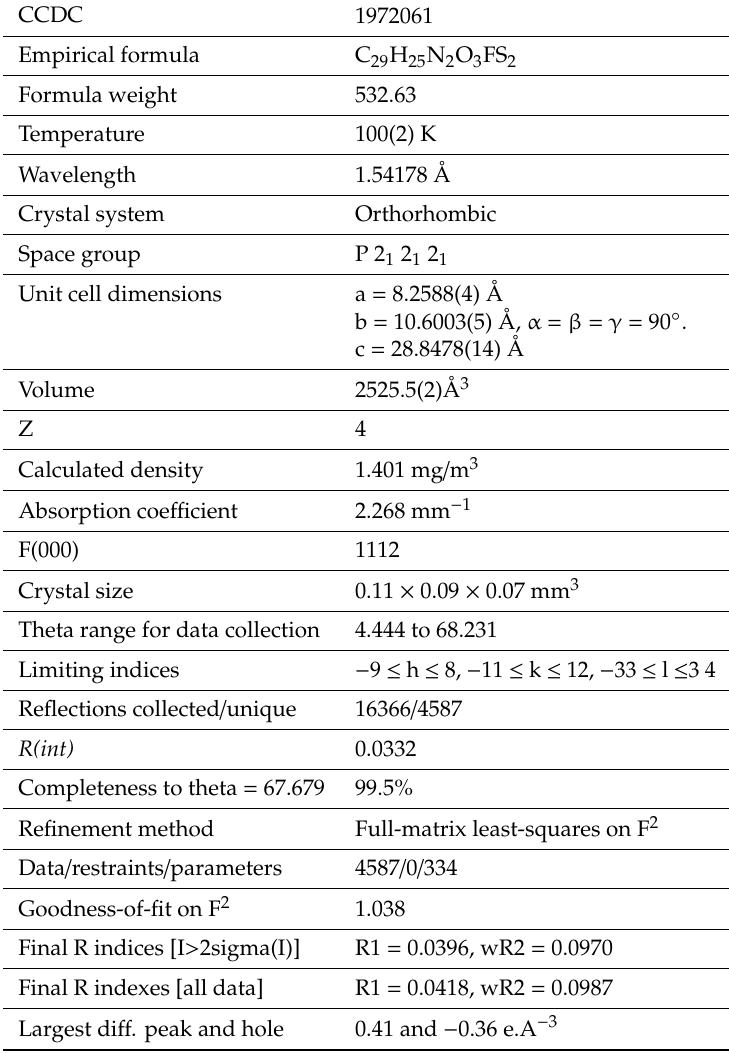
Table 1. Experimental and refinement details of compound 5